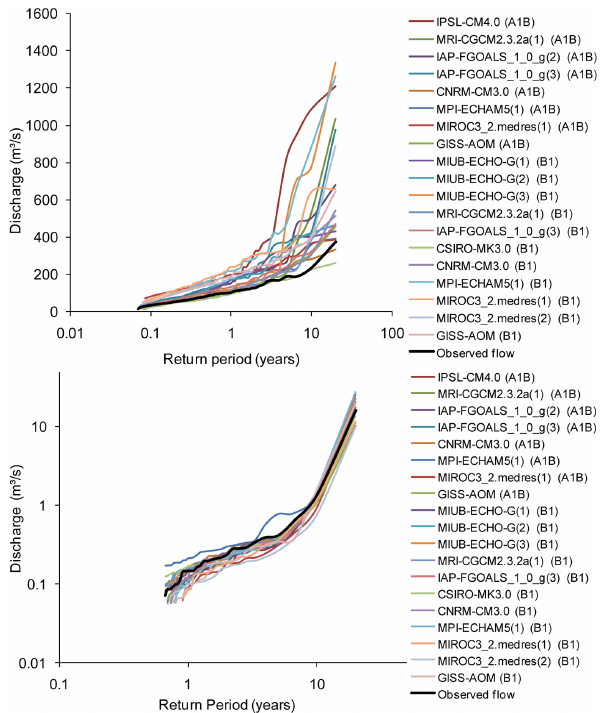
Fig. 9. Return period of daily peak flow extremes (top) and low flow extremes (bottom) for Nyando catchment, for control period (1971– 1990) and future period (2046–2065) based on different GCM runs (VHM) results.